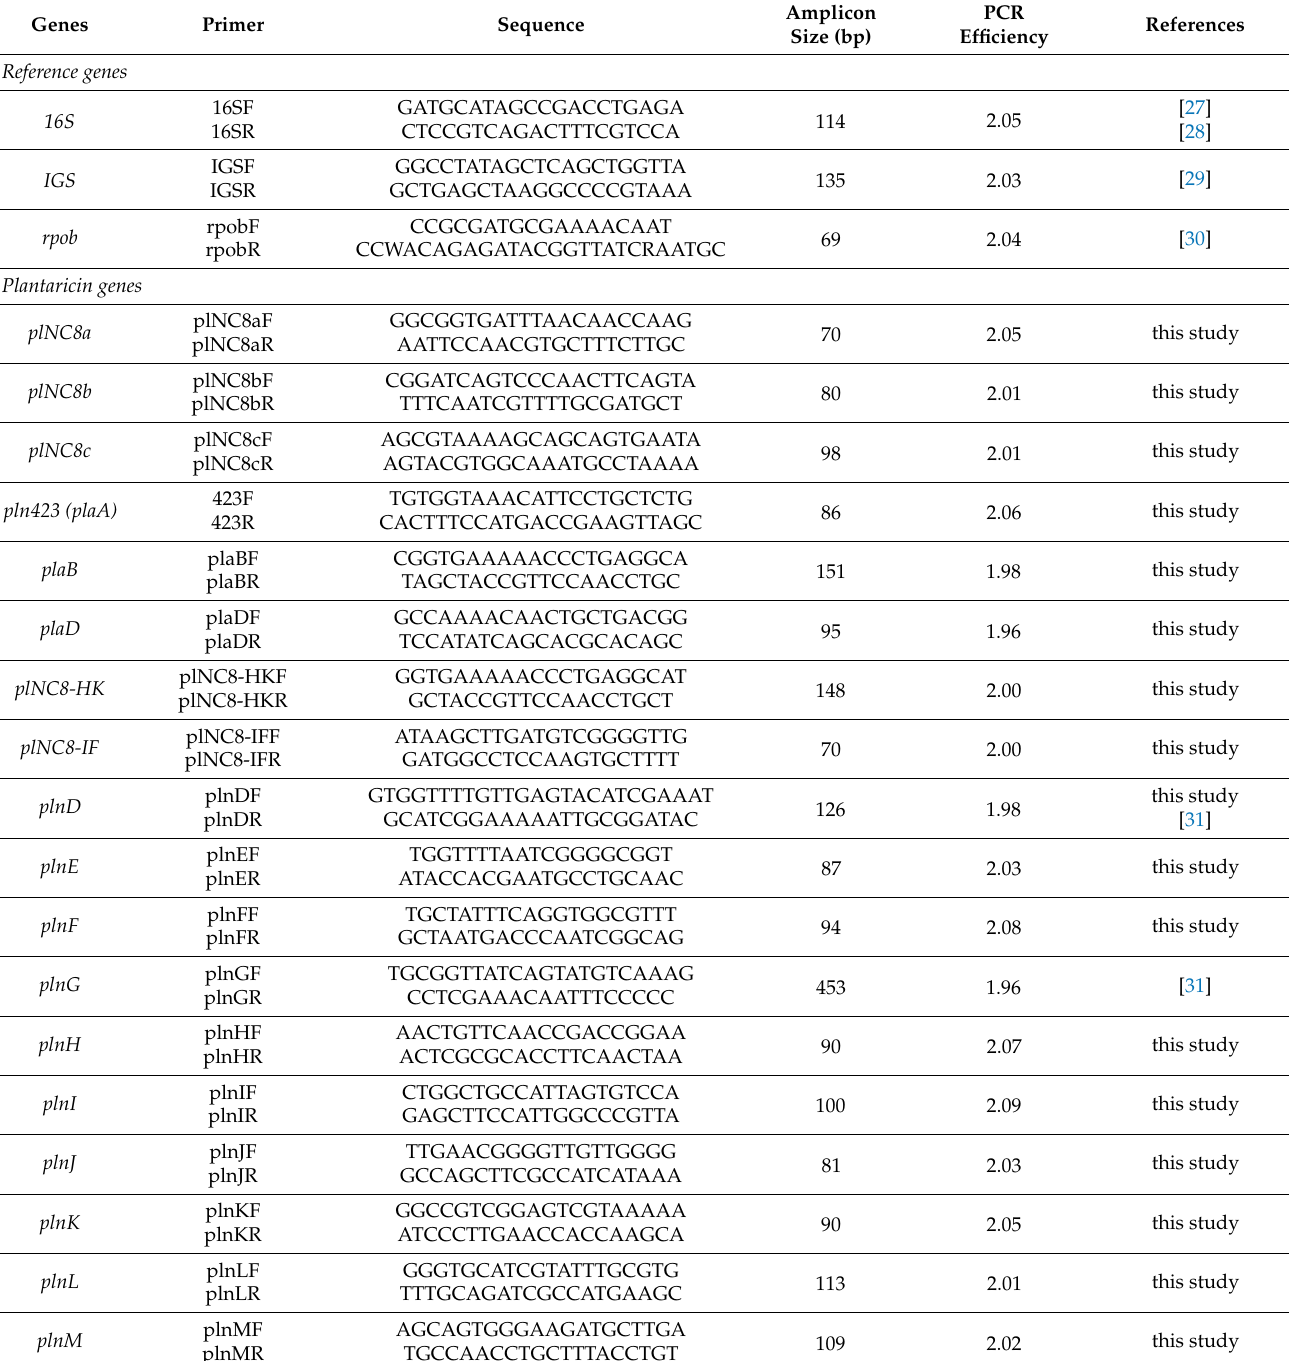
Table 1. Primer sequences and respective amplicon sizes used for the gene transcription